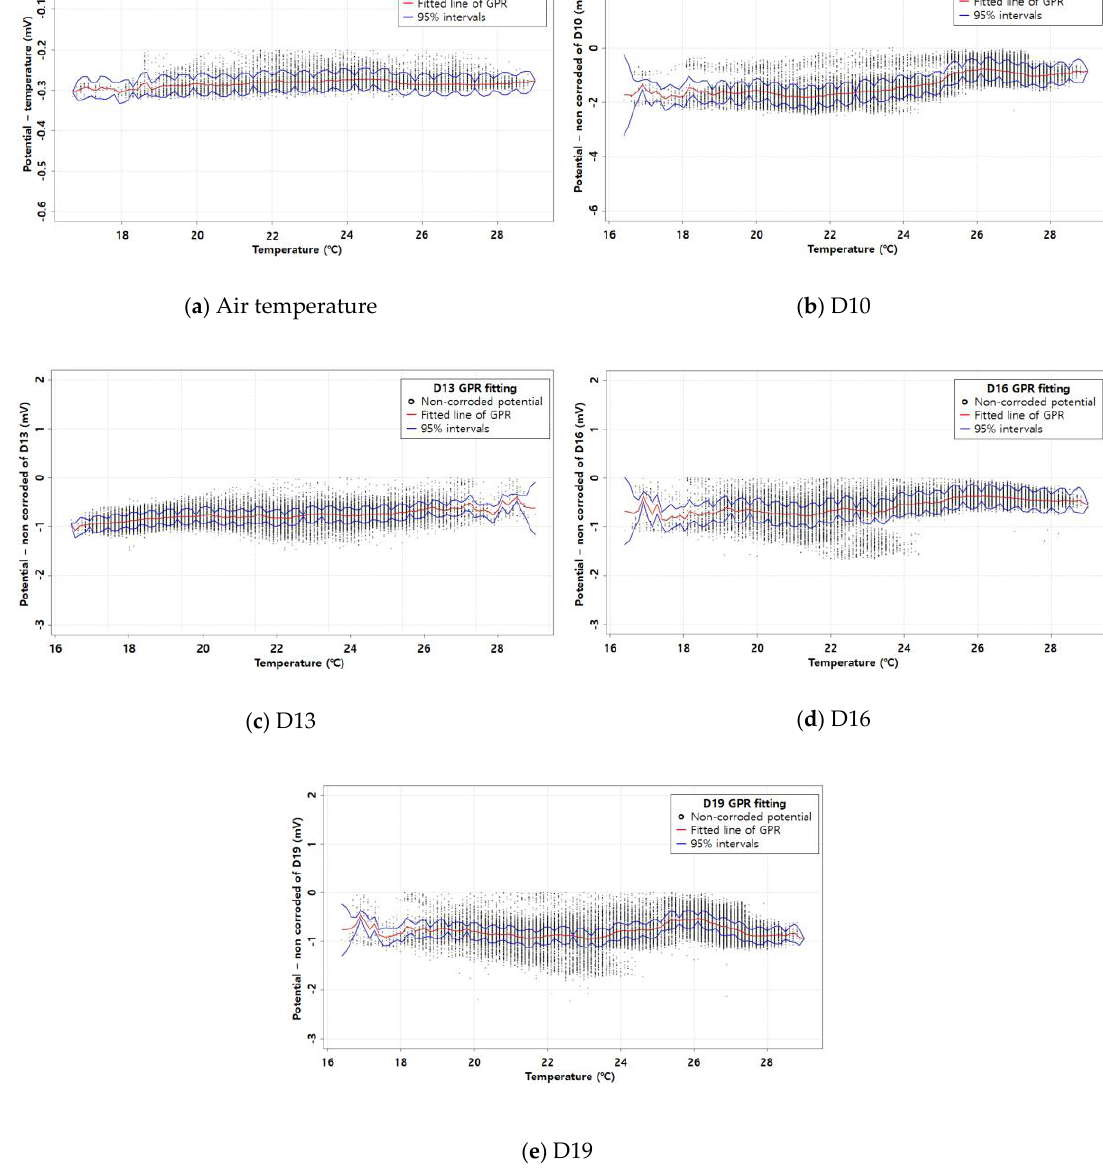
Figure 4. The fitting results: ( a ) air temperature; ( b ) D10; ( c ) D13; ( d ) D16; ( e ) D19.